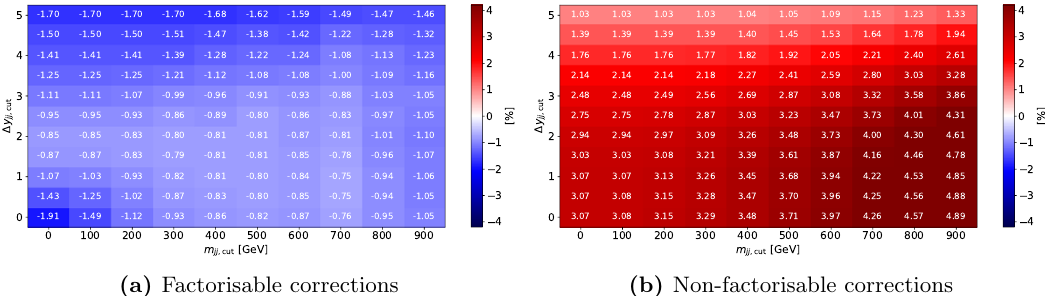
Figure 2. Double Higgs VBF production: ratio of the factorisable (a) and non-factorisable (b) NNLO corrections relative to LO for (cid:12)ducial cross sections with two R = 0 : 4 anti- k t jets satisfying p t > 25 GeV and y j < 4 : 5, as a function of the m jj and (cid:1) y jj selection j j